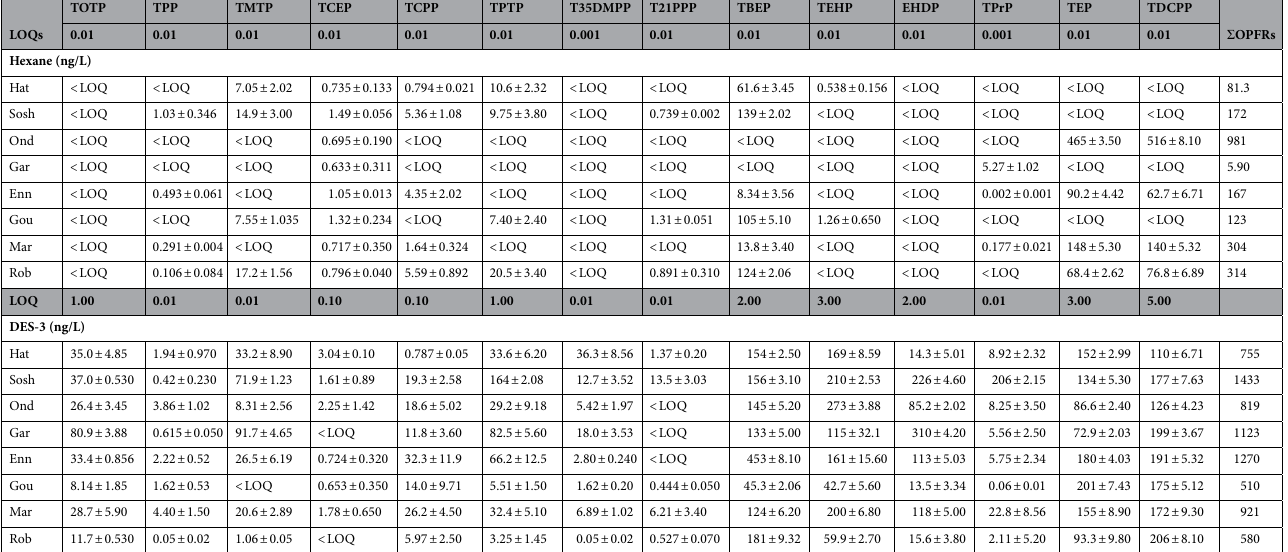
Table 5. Mean (n = 2) OPFR concentrations ± SD in the leachate (ng/L) from eight selected landfill sites extracted using hexane and DES-3. Ond = Onderstepoort, Gar = Ga-Rankuwa, Sosh = Soshanguve, Hat = Hatherly, Enn = Ennerdale, Rob = Robinson Deep, Mar = Marie Louise, n = number of sample replicates per landfill